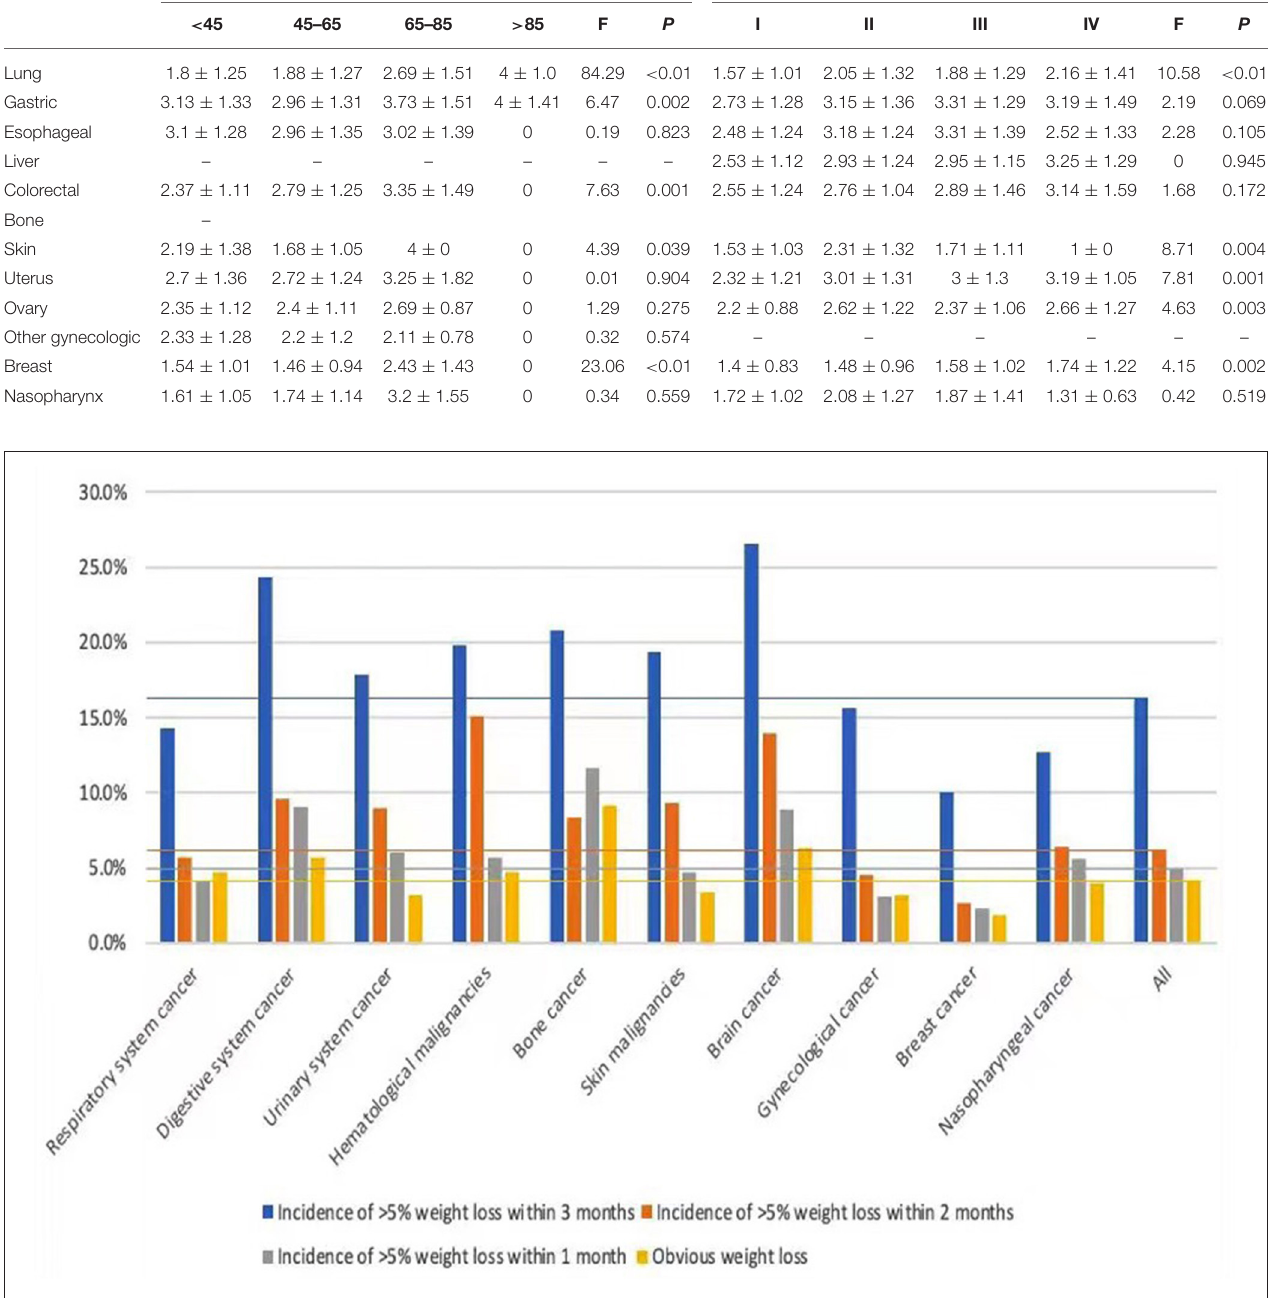
TABLE 2 | NRS-2002 score of subjects according to different age and TNM staging. Cancer type